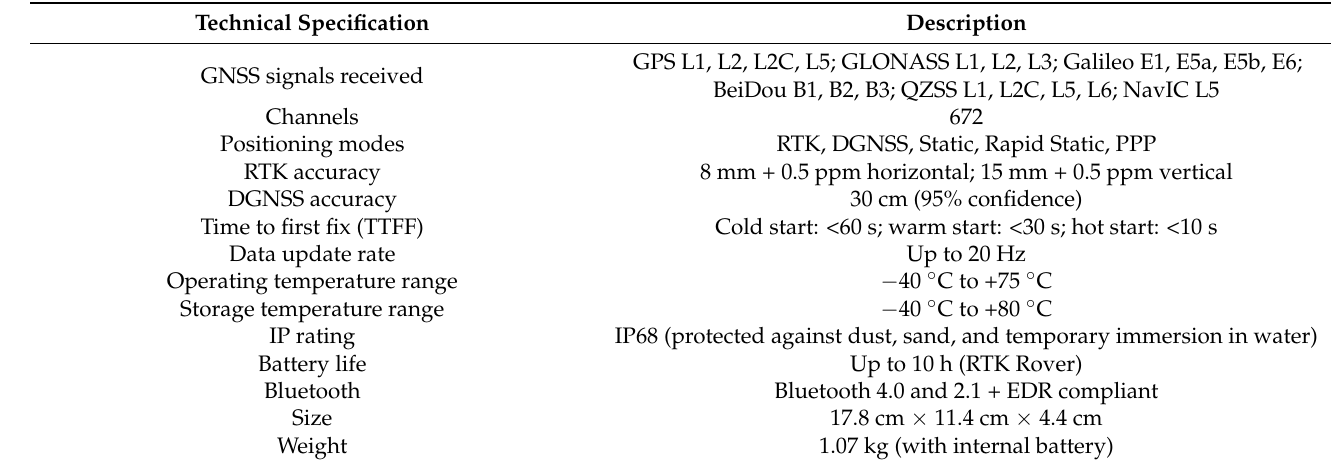
Table 1. Technical specifications of the Trimble R12 GNSS